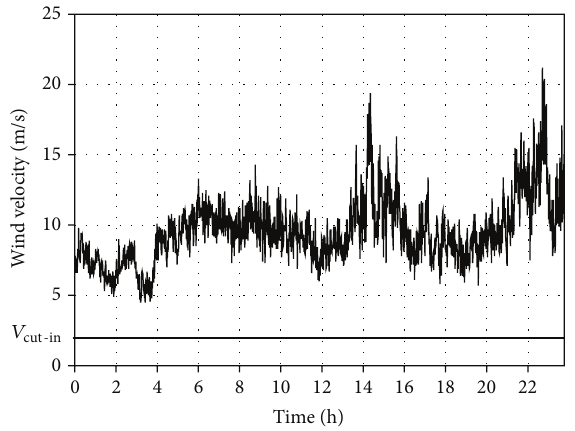
Figure 2: Circadian wind velocity changes recorded on 5 March 2008 in Strzy˙z´ow (South Eastern Poland) at the height of ℎ 𝑝 = 10 m above the ground